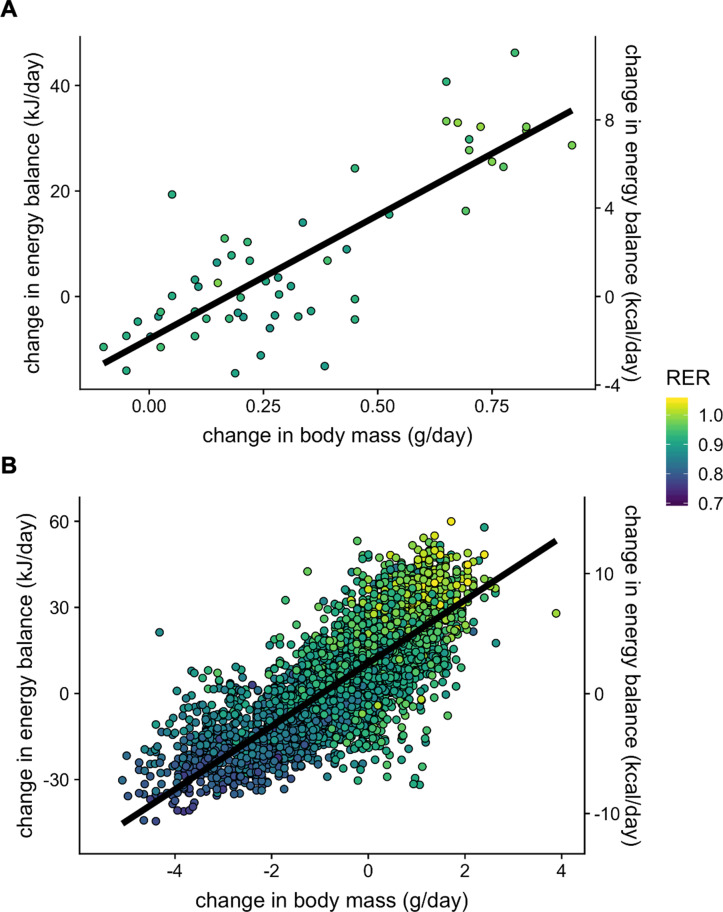
IMPC experiment: body weight and metabolic rate.Plot of EE vs total mass for 4 body mass groups (small, 14.00–20.75 g; medium, 20.75–27.50 g; large, 27.50–34.25 g; largest, 34.25–41.00 g) (A). Relationship between the group with large masses is significant from small mass and medium mass groups. No other group relationships are significant. EE vs lean mass (small, 8.70–13.92 g; medium, 13.92–19.14 g; large, 19.14–24.36 g; largest, 24.36–29.60 g). No group relationships are significant. (B). *, p<0.05. n = 6469 males and 2889 females.